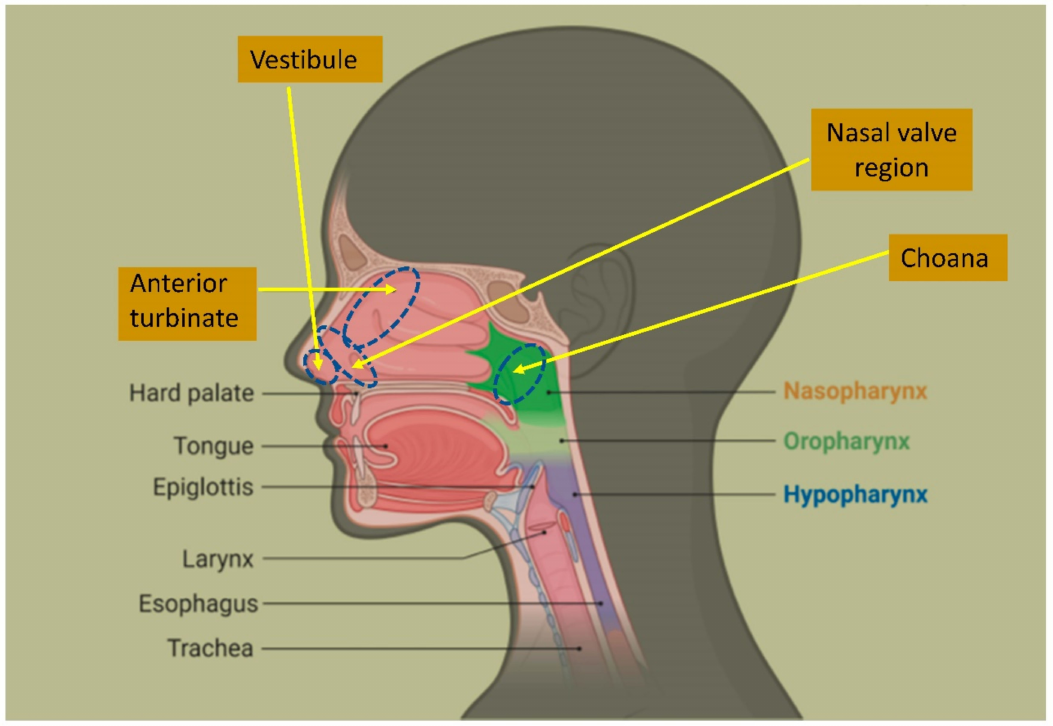
Figure 2. Anatomy of the nasal